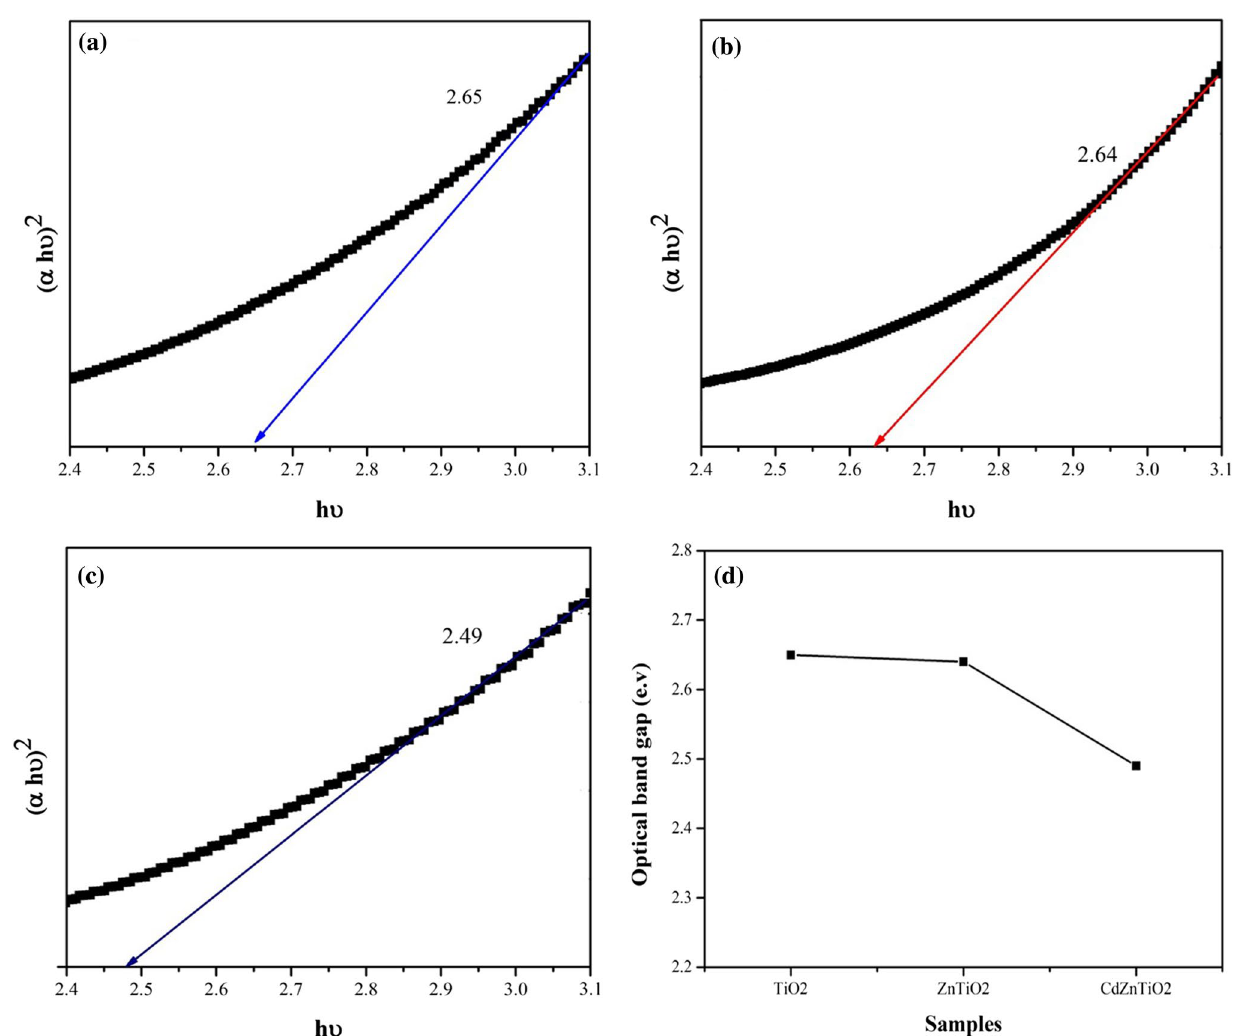
Fig. 6 Tauc plots: ( α hv) 2 versus energy for the a TiO 2 , b ZnTiO 2 , c CdZnTiO 2 , d optical band gap variation of TiO 2 and ZnTiO 2 , CdZnTiO